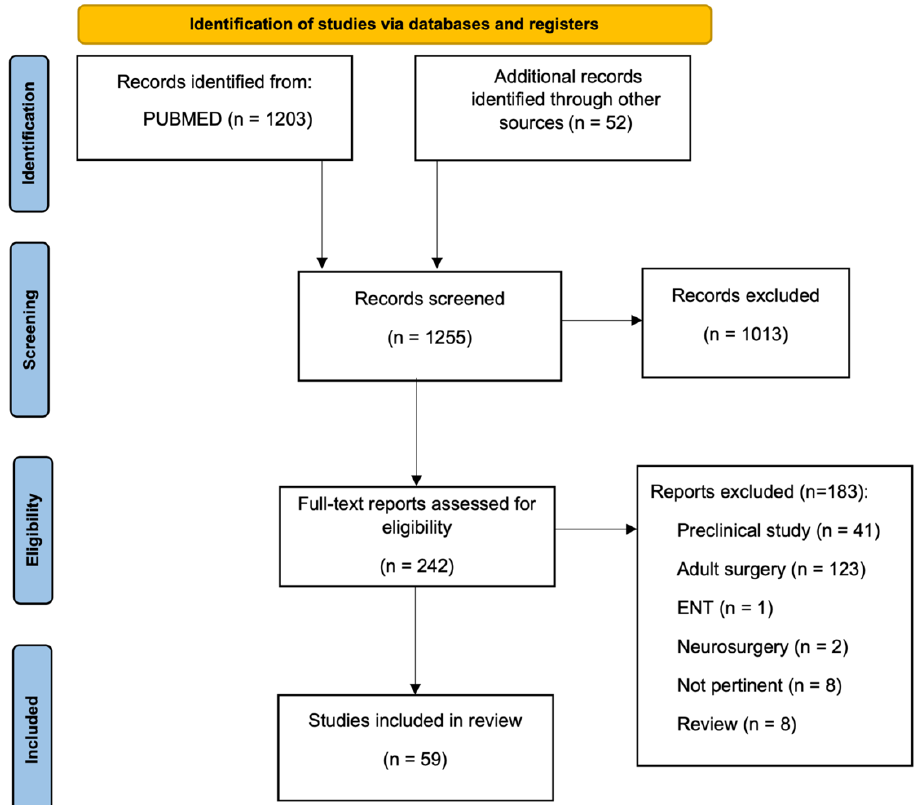
Figure 2. PRISMA flowchart. Abbrev. ENT: otolaryngology.